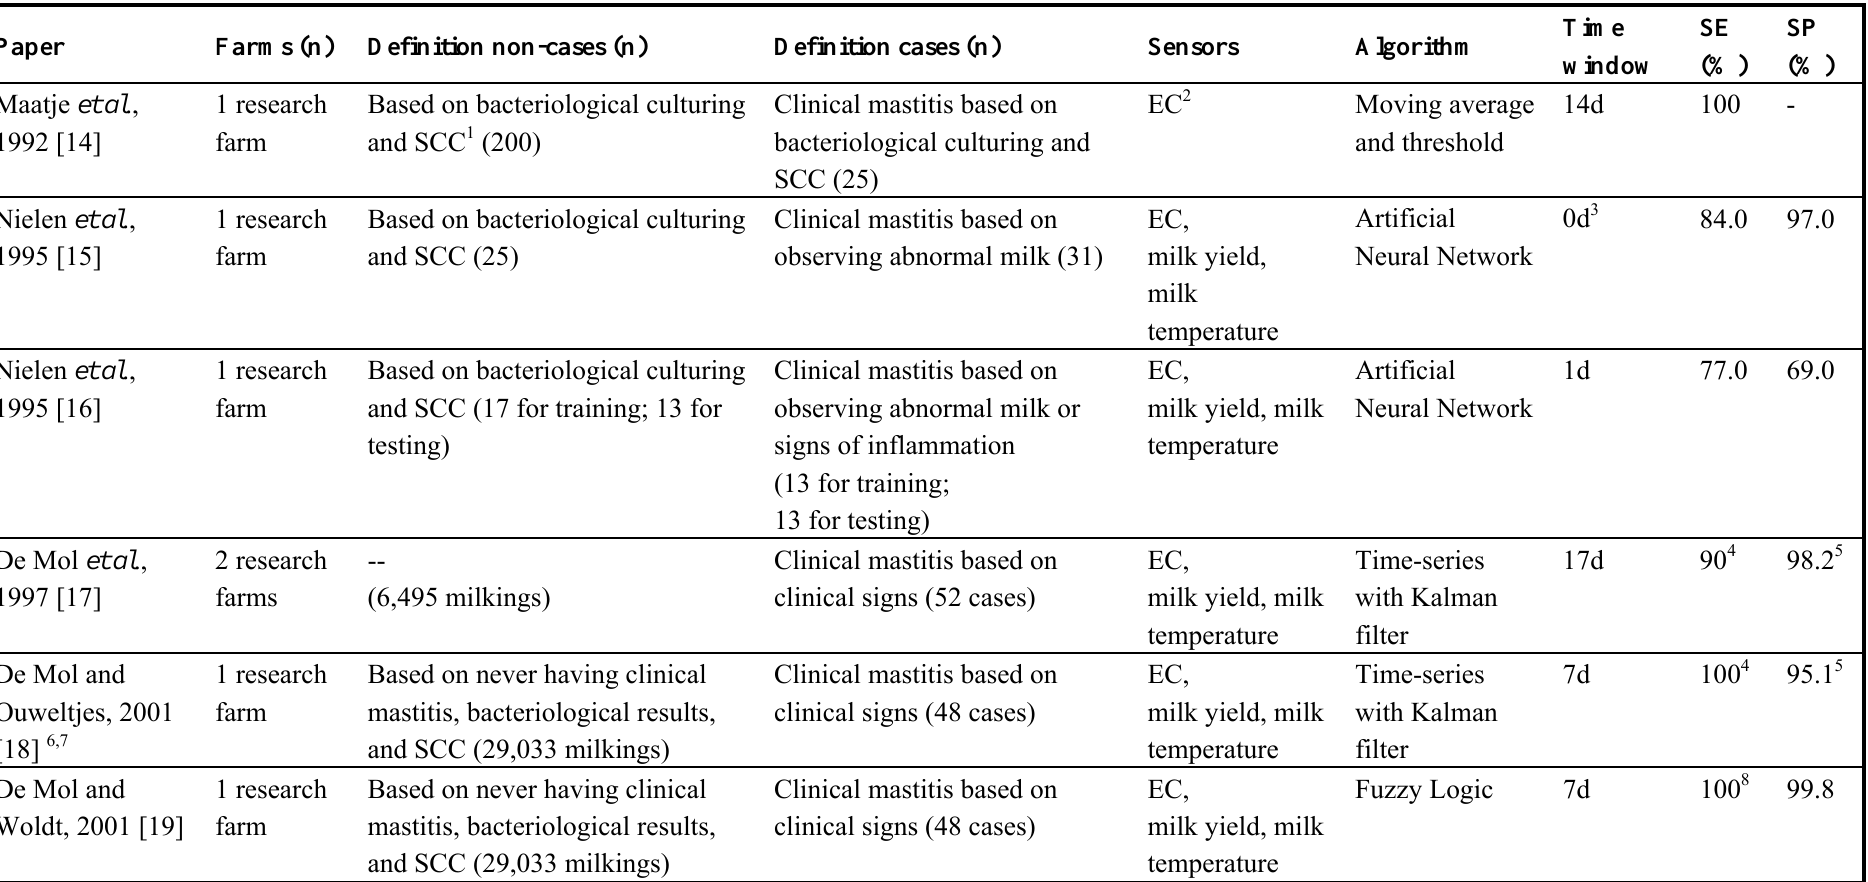
Table 1 . Study characteristics of peer-reviewed published studies conducted from 1990 onwards that used sensor information (in- and online) for the detection of clinical mastitis. Characteristics included are the number of farms, definition of non-cases and cases and the number of them included in the study, sensors used, the applied methodology, the time window applied for classification, the sensitivity (SE), and the specificity